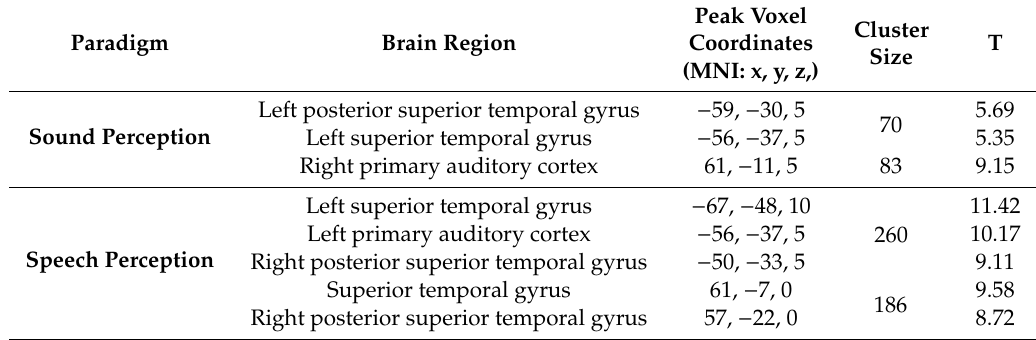
Peak Voxel Coordinates